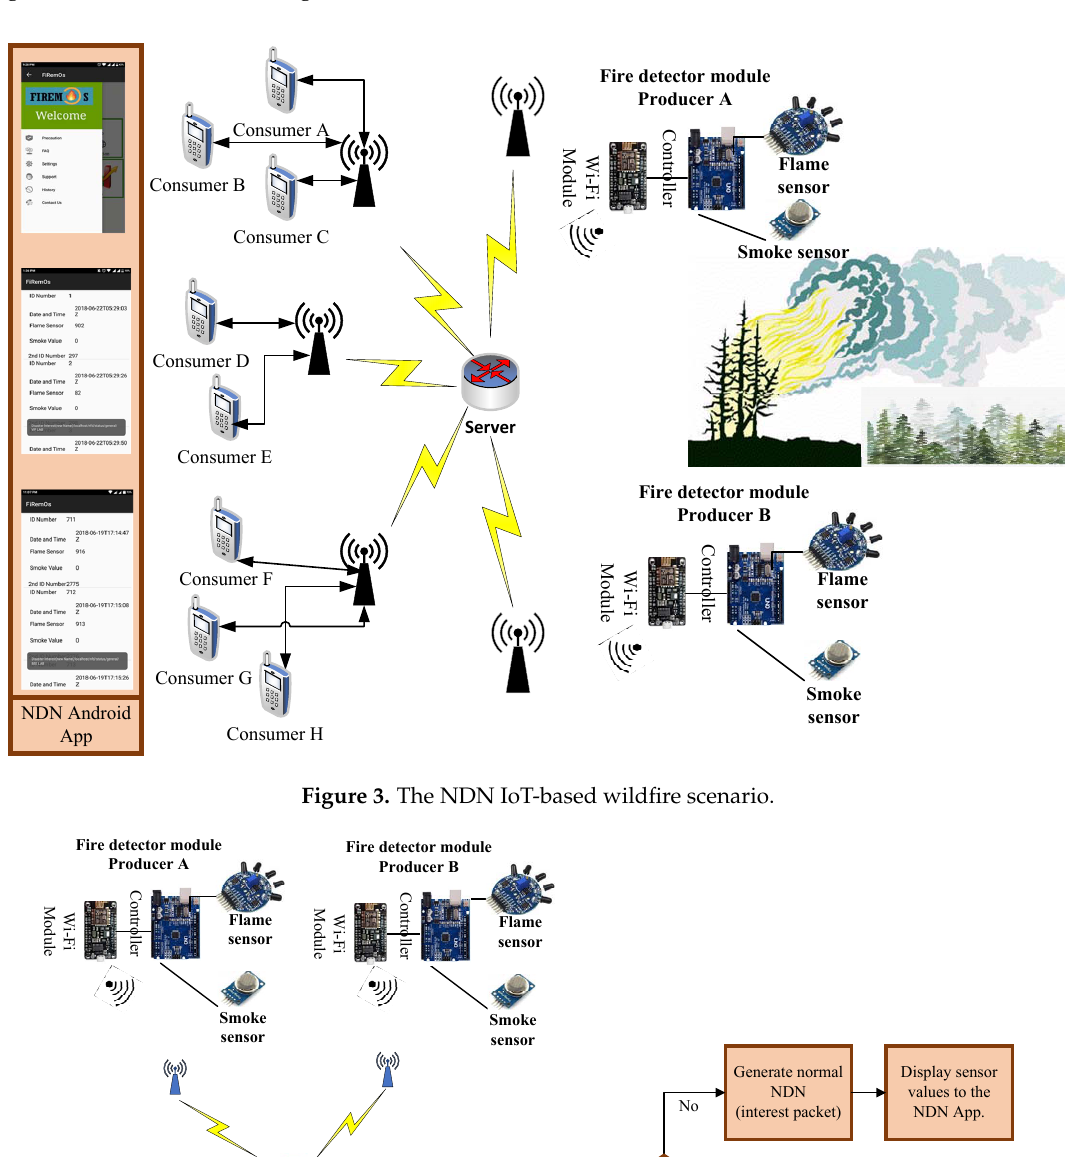
Figure 4. Block diagram of teh NDN wildfire detection